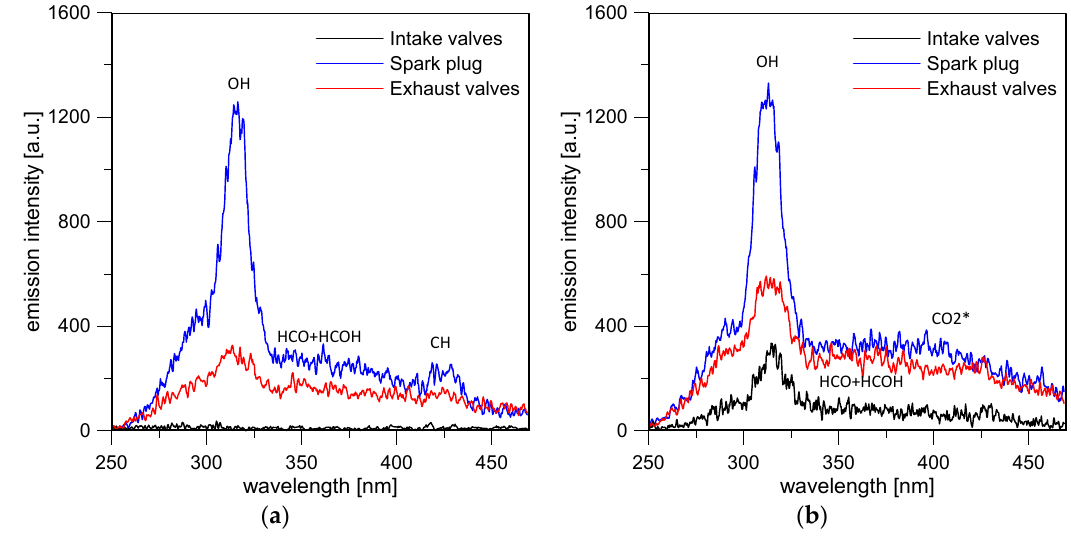
Figure 13. UV-visible spectra detected in three regions of the combustion chamber at 15 CAD ASOS ( a ) and 18 CAD ASOS ( b ) for stoichiometric operation.